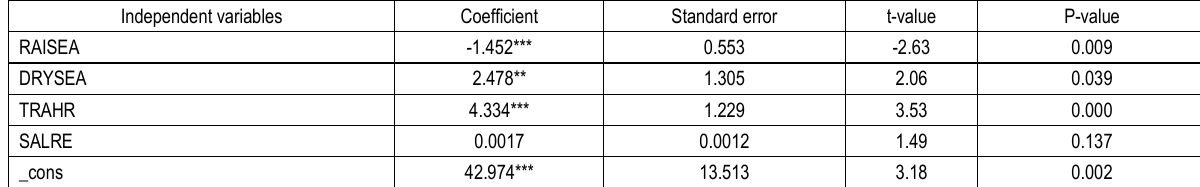
Table 8.(cont.) Result of multiple regression